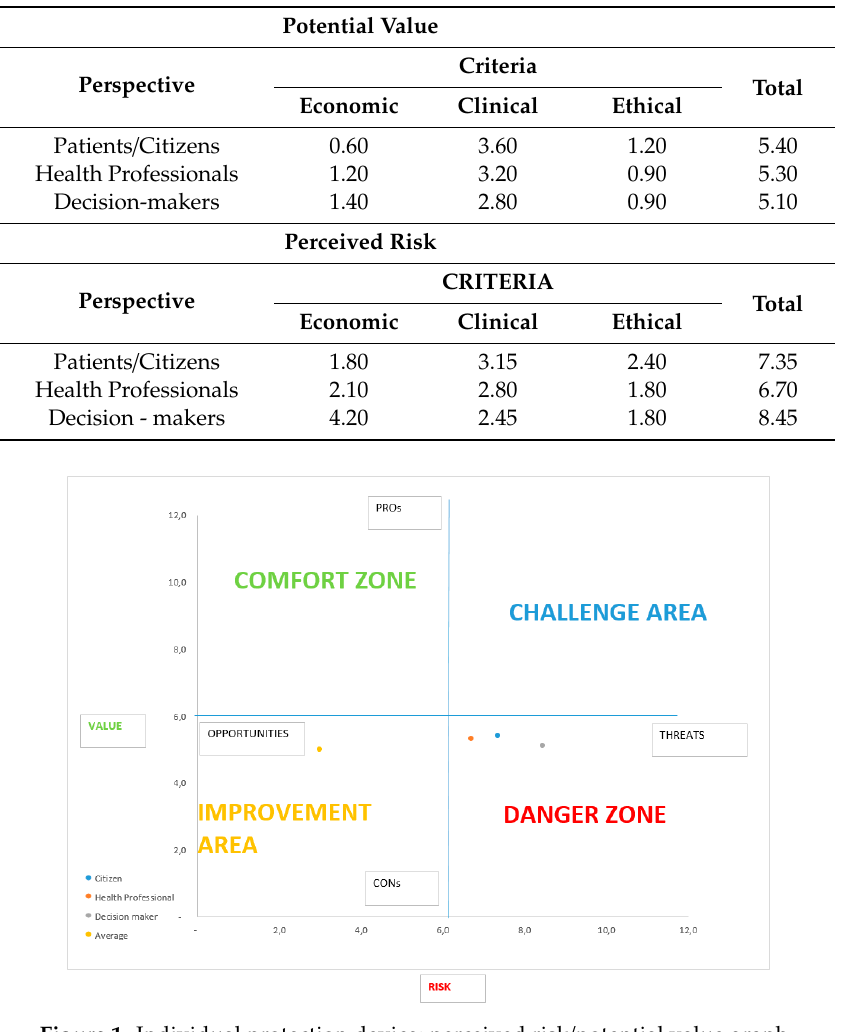
Figure 1. Individual protection device; perceived risk/potential value graph.